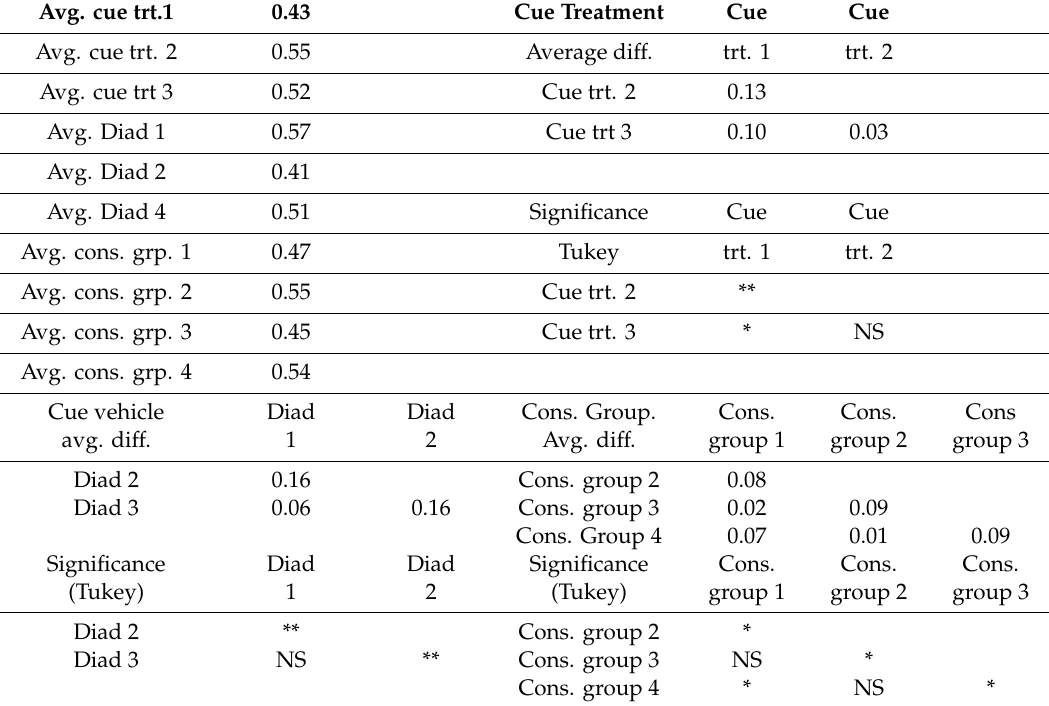
Table 2. Significance of di ff erence between multiple means table (after